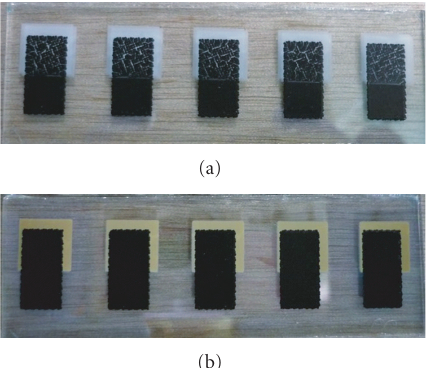
Figure 5: Photos of annealed carbon electrodes in monolithic DSCs: (a) without preannealing and (b) with preannealing.